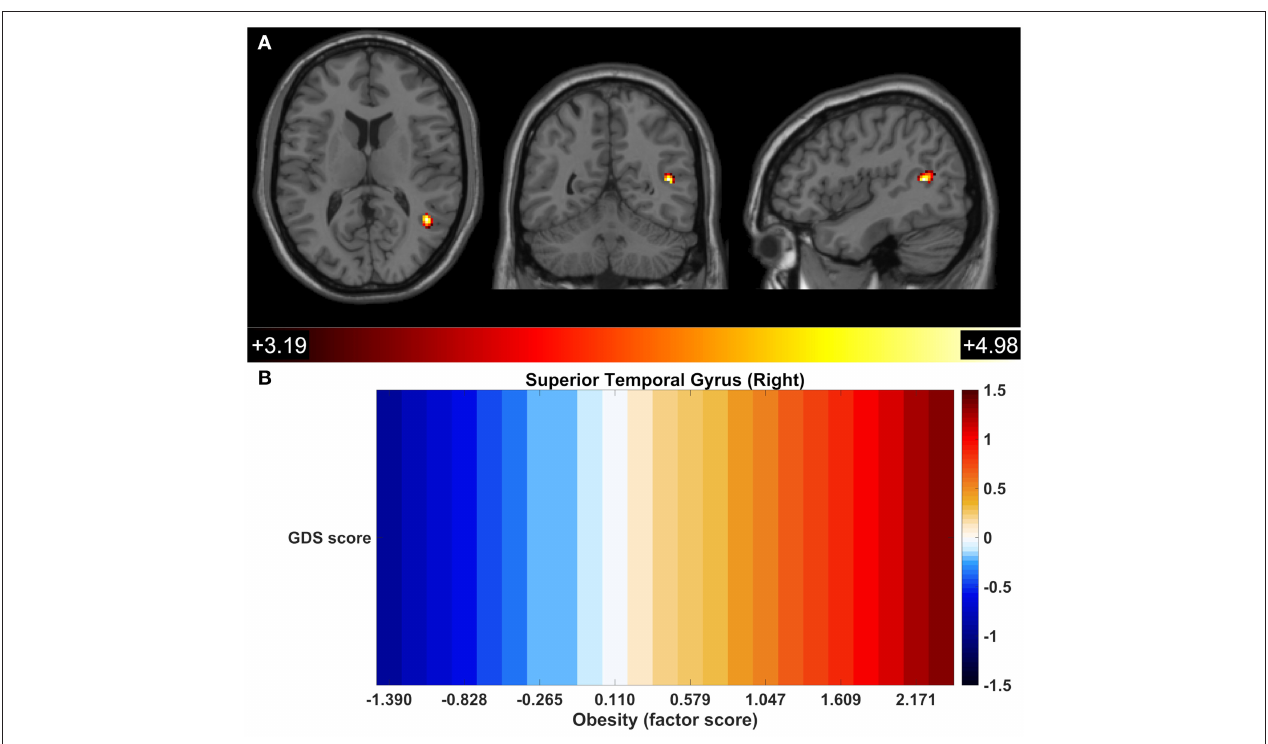
FIGURE 5 | Functional connectivity between a focal region of the right superior temporal gyrus and the other components of the DMN reflected GDS-obesity interaction. DMN regions presenting significant interactions of GDS x Obesity (A) . Association of the GDS score with the FC of the right superior temporal gyrus across obesity score; colors represent standardized coefficients ( β ) (B) .